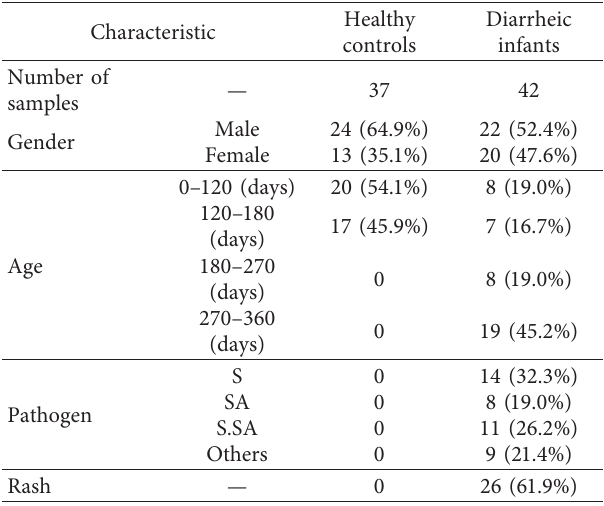
Figure 1: The flowchart of sample collection and grouping in this study. S: Salmonella ; SA: Staphylococcus aureus . Table 1: The basic clinical information on healthy infants and infants with